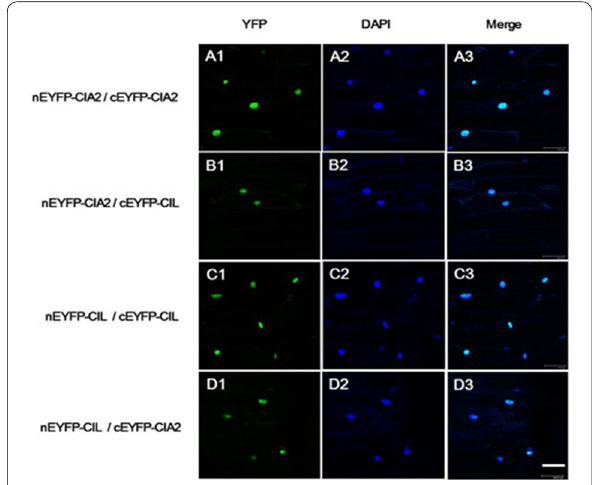
Fig. 4 In planta interactions of CIA2 and CIL, as assessed by BiFC. Plasmids expressing nEYFP‑CIA2, cEYFP‑CIA2, nEYFP‑CIL, or cYFP‑CIL were co‑transformed into onion epidermal cells by particle bombardment. A1 to D1, visualization of YFP signal. A2 to D2, visualization of DAPI staining. A3 to D3, superimposition of YFP and DAPI staining. YFP, yellow fluorescent protein. DAPI, nucleic acid dye. nEYFP, 1‑173 aa fragment of the N terminus of eYFP; cEYFP, 174‑328 aa fragment of the C terminus of eYFP. Scale bar represents 100